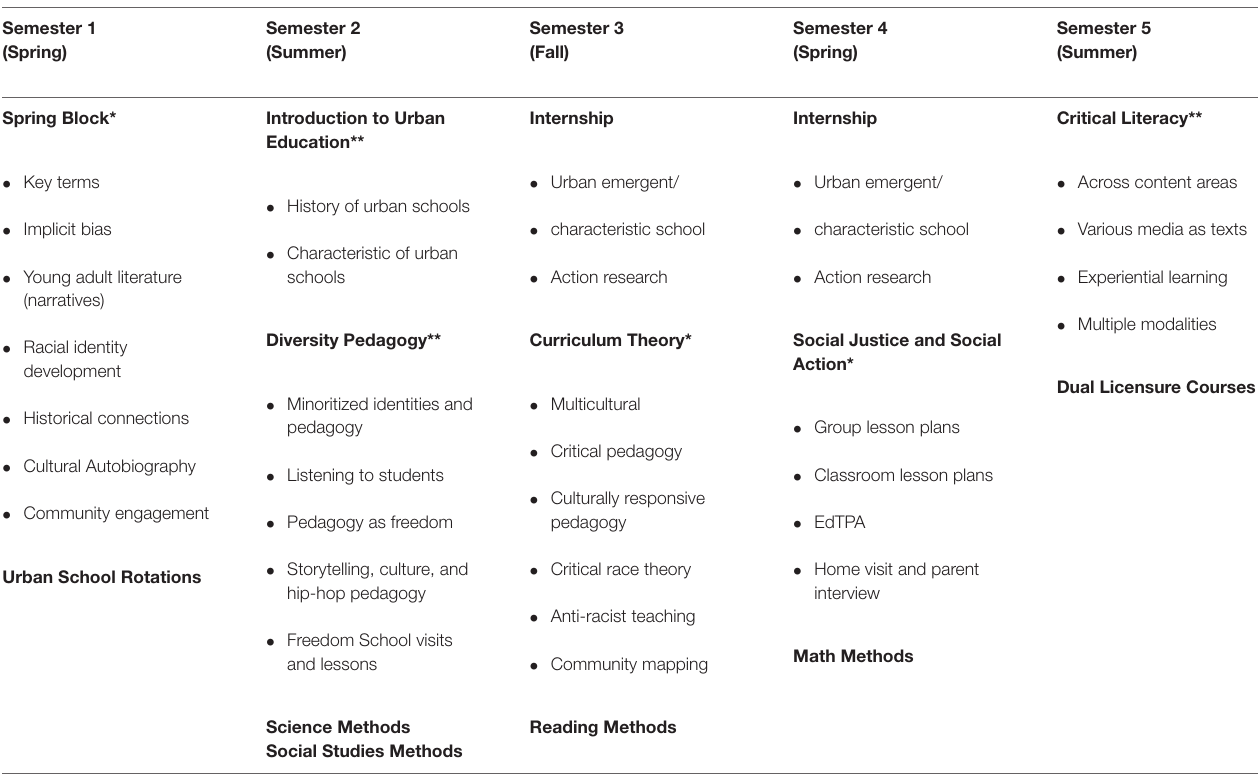
TABLE 1 | UTPP curriculum